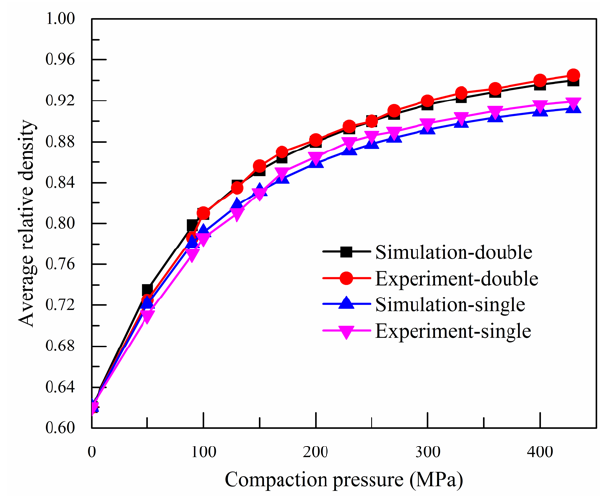
Figure 6. Variation of average relative density with compaction pressure for simulation and experiment. Table 1. Fitting parameters of compaction equations for simulation and experiment.